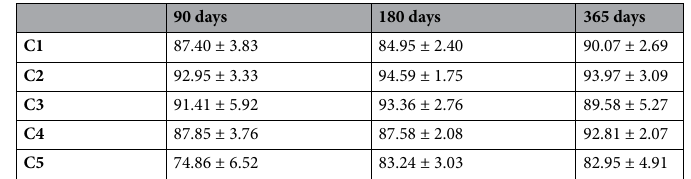
Table 10. Summary of the best AUC results obtained with the triclustering-based classification approach with static features added for each of the target endpoints according to each of the considered time windows. These results considered the best parameters and classifiers as depicted in Table 8. C1, need for NIV; C2, need for an auxiliary communication device; C3, need for PEG; C4, need for a caregiver, and C5, need for a